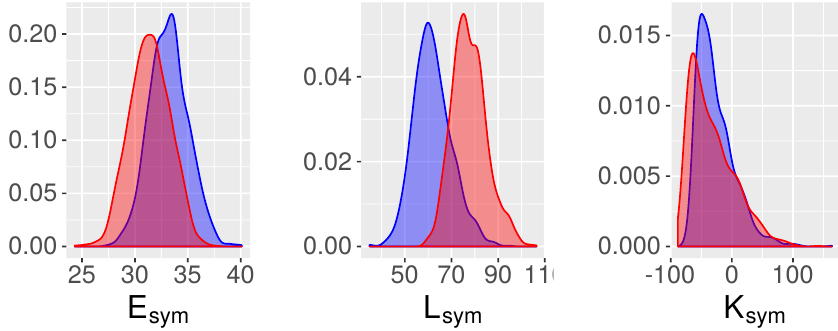
Figure 1. Probability density functions for E sym , L sym , and K sym using both crust matching procedures: P ( µ t ) (blue) and P ( (cid:101) t ) (red).